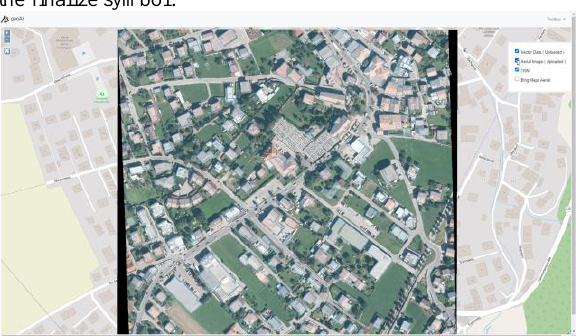
Figure 7. All modifications applied on the uploaded vector data are committed in the spatial database immediately after clicking the finalize symbol.